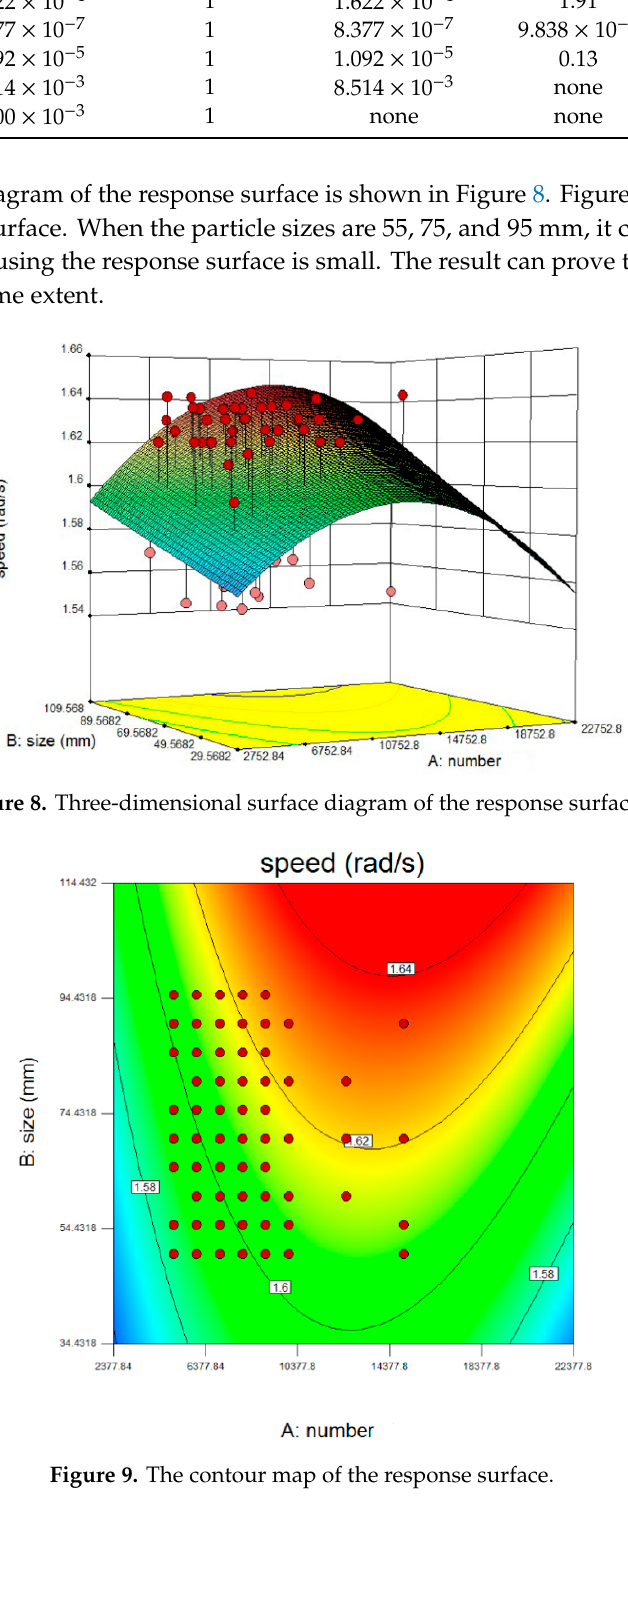
Table 3. Variance analysis.